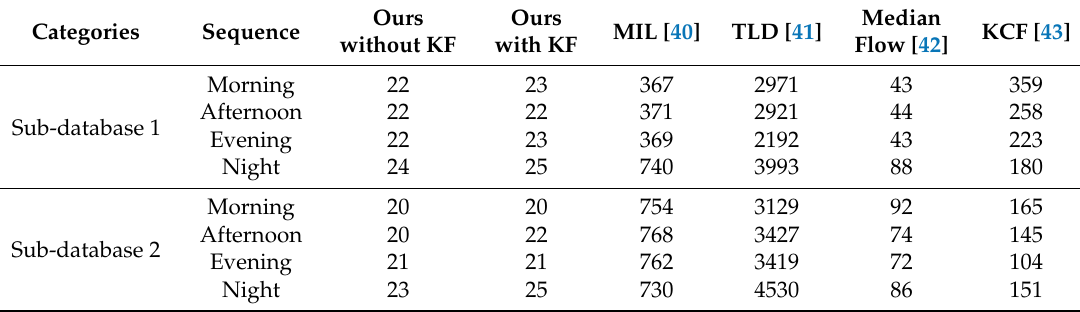
Table 5. Comparisons of average processing time achieved by our proposed method with those obtained by other methods